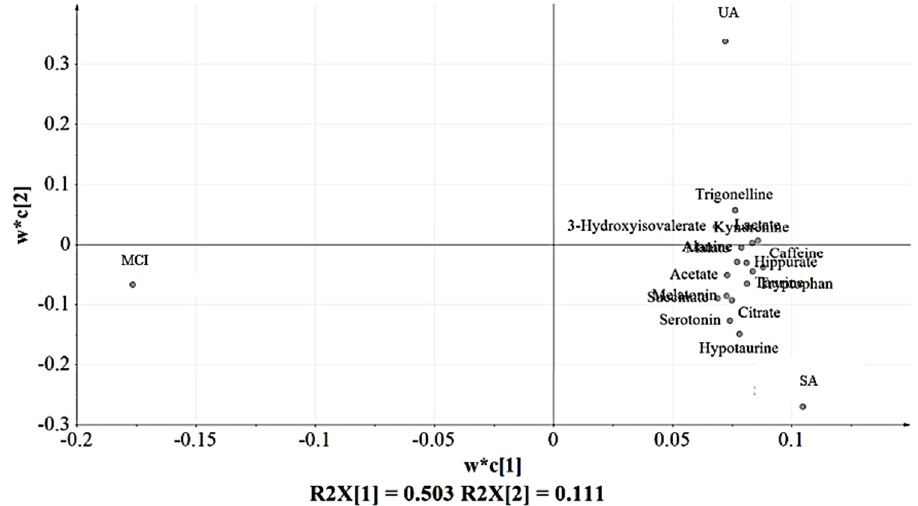
Figure 4. The PLS-DA loading plot with the putatively identified urinary metabolites mostly found in the positive side of PC1 (w*c(1)) corresponding to UA and SA of the score plot (Figure 3).